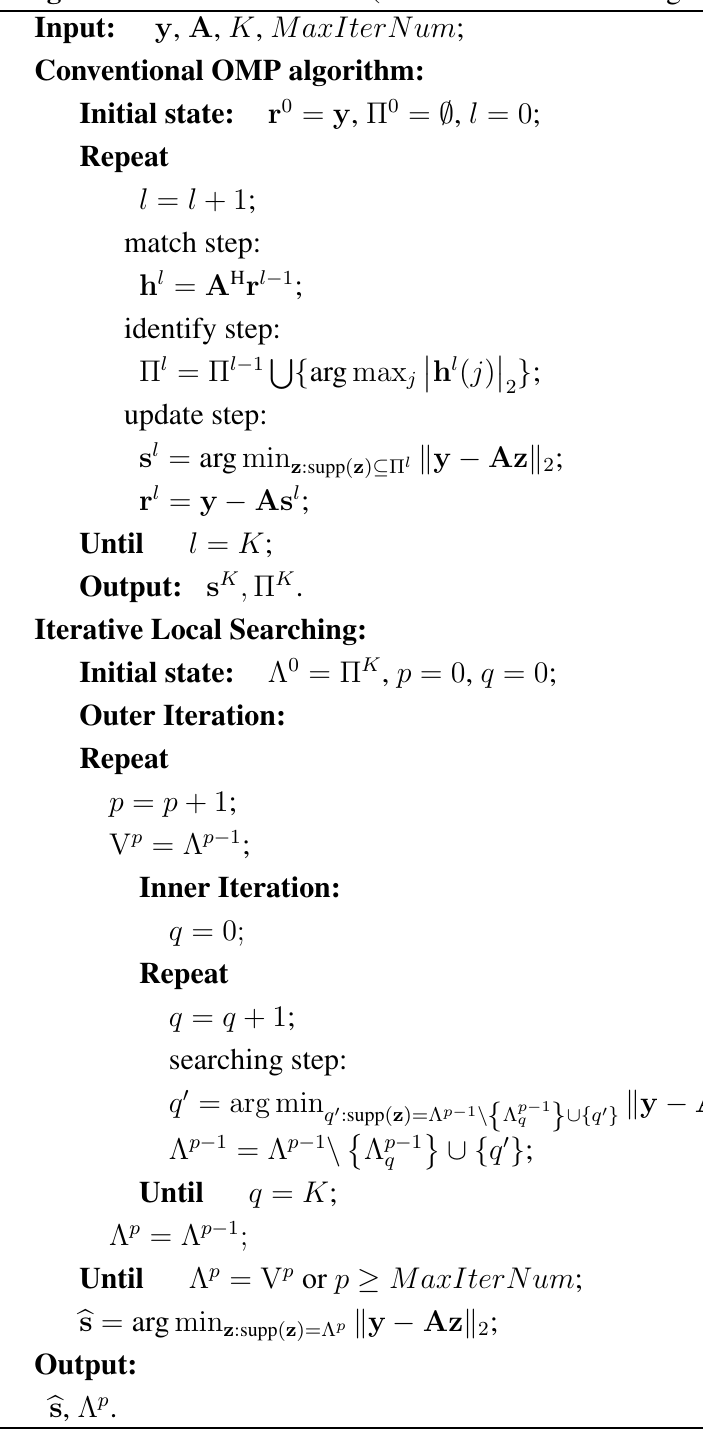
Algorithm 2: The ILS-OMP (Iterative Local Searching - Orthogonal Matching Pursuit)